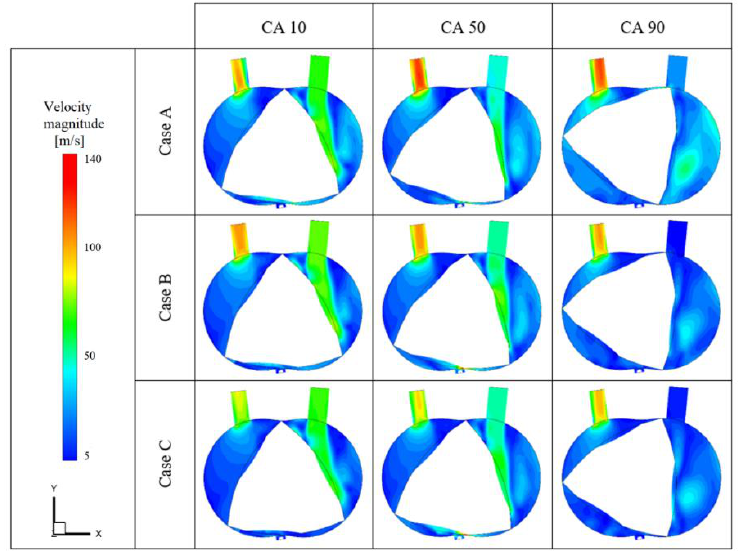
Figure 15. Velocity magnitude distribution at the middle plane of the front view for different cases at CA 10, CA 50 and CA 90.